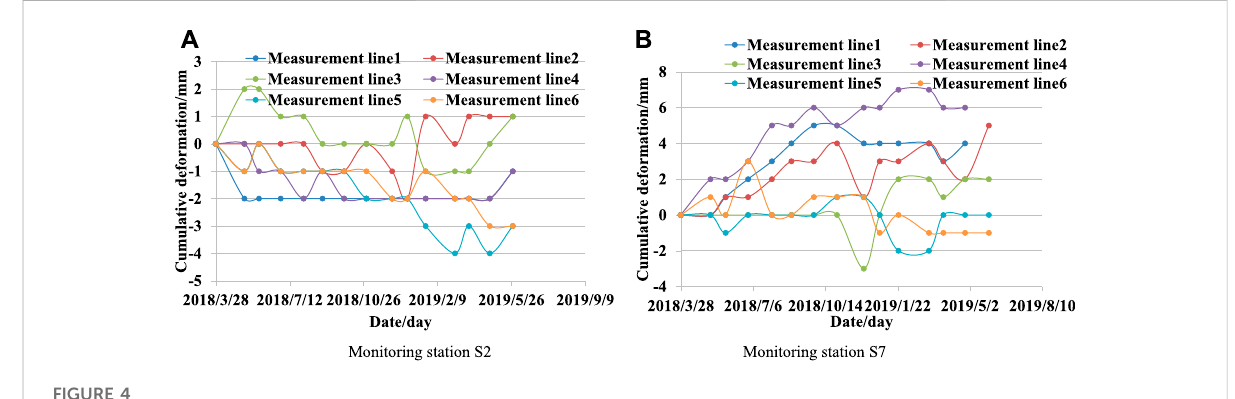
FIGURE 4 Displacement – time curve of the monitoring stations between exploration line 32-1 and exploration line 34. (A) Monitoring station S2. (B) Monitoring station